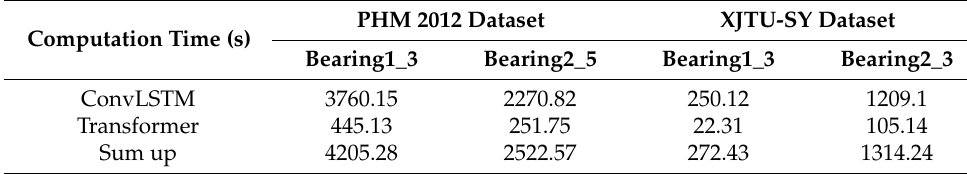
Table 3. Computation cost results of the propose method.